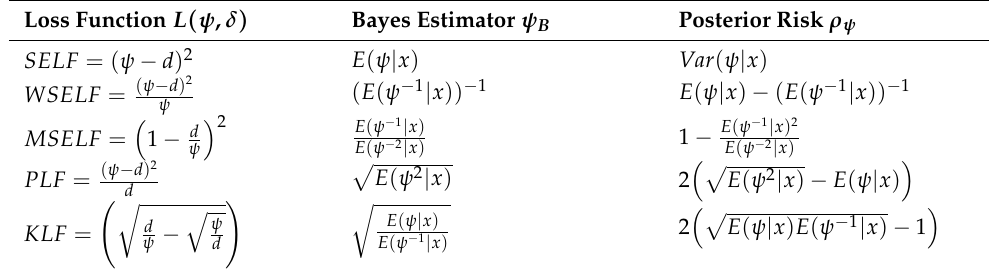
Table 1. Bayes estimator and posterior risk under several loss functions. Loss Function L ( ψ , δ ) Bayes Estimator ψ